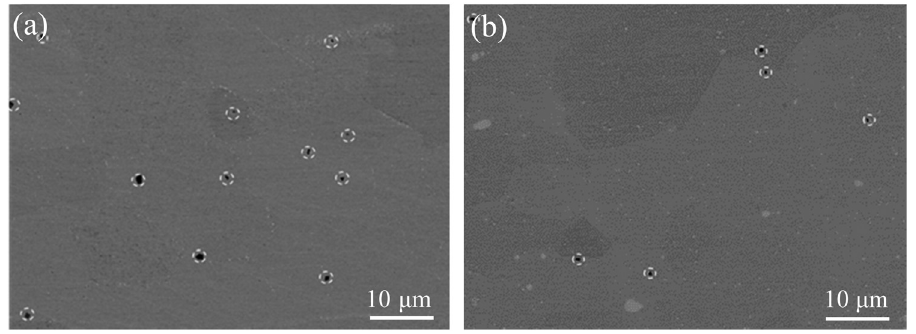
Figure 1: Back - scattered electron images of inclusions in ferritic stainless steel samples: ( a ) FSS1 and ( b )